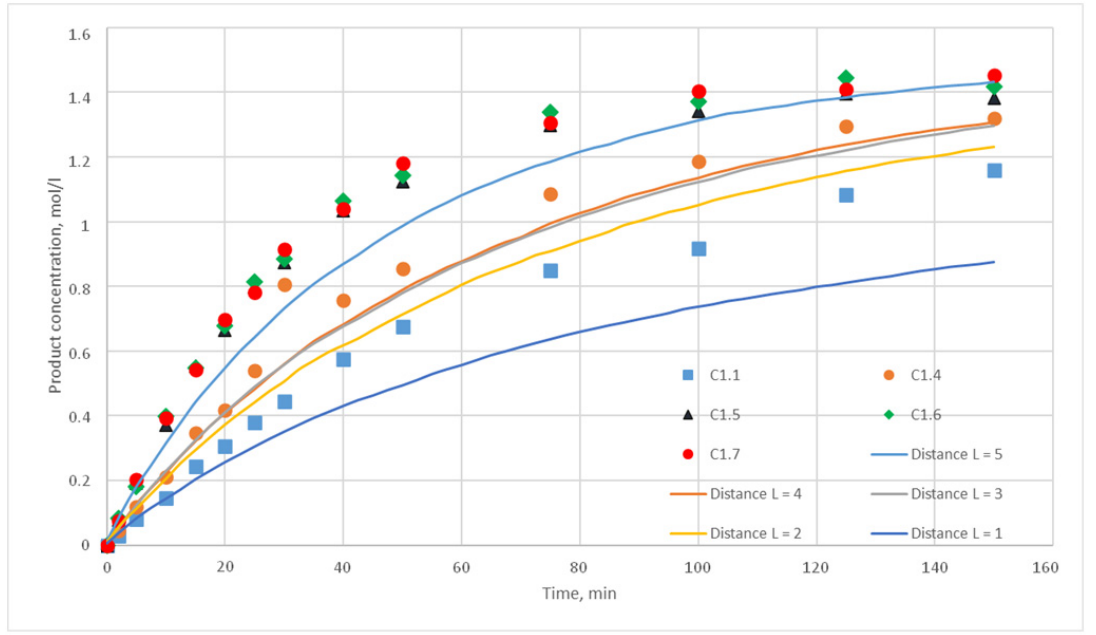
Figure 14. Calculation and experimental reaction kinetic curves. Reaction probability p = 0.010. Lines—calculation curves, points—experimental data.